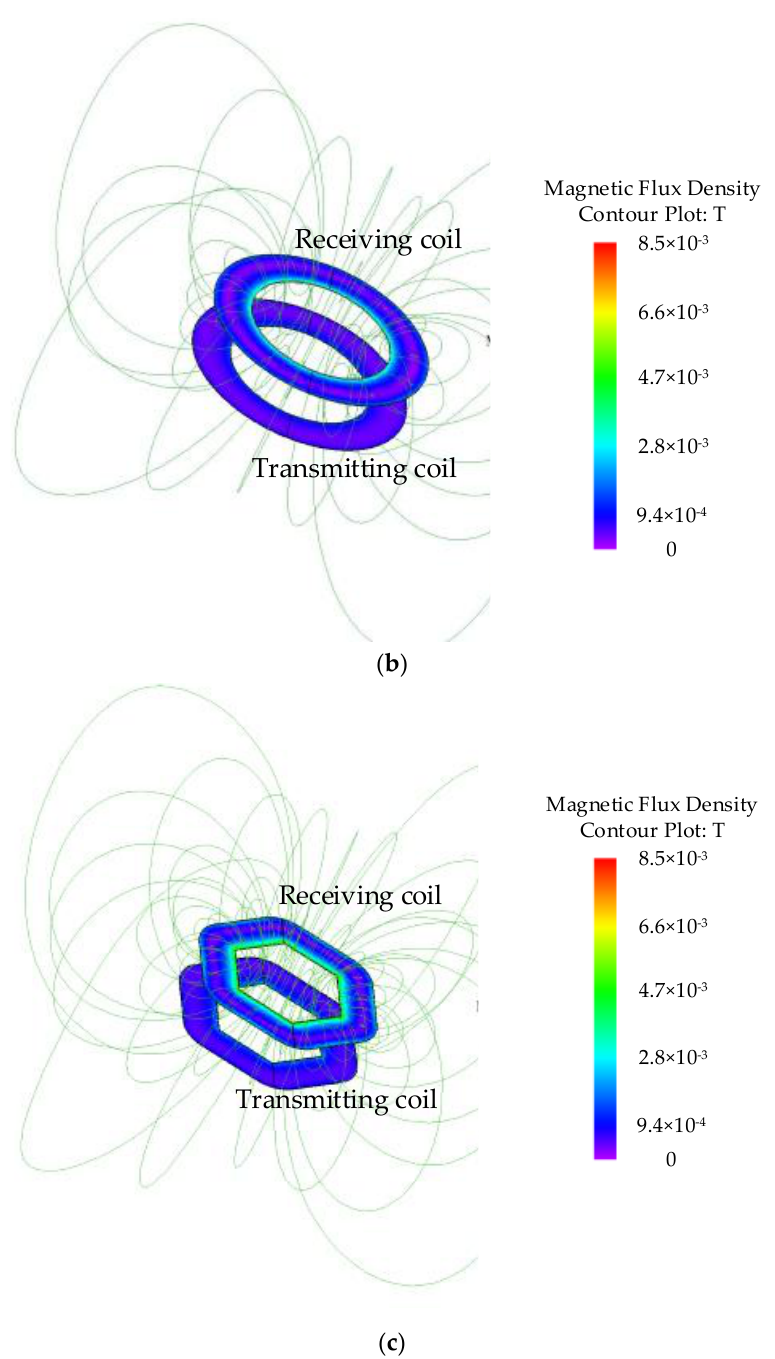
Figure 3. Contour graphs of magnetic flux distributions. ( a ) Rectangular couplers; ( b ) Circular couplers; ( c ) Hexagonal couplers.